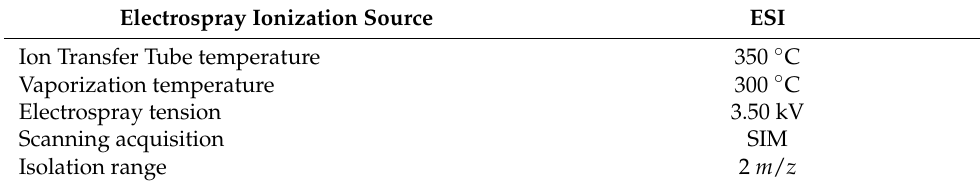
Table 4. Instrumental Conditions for HPLC–MS-MS Analysis.